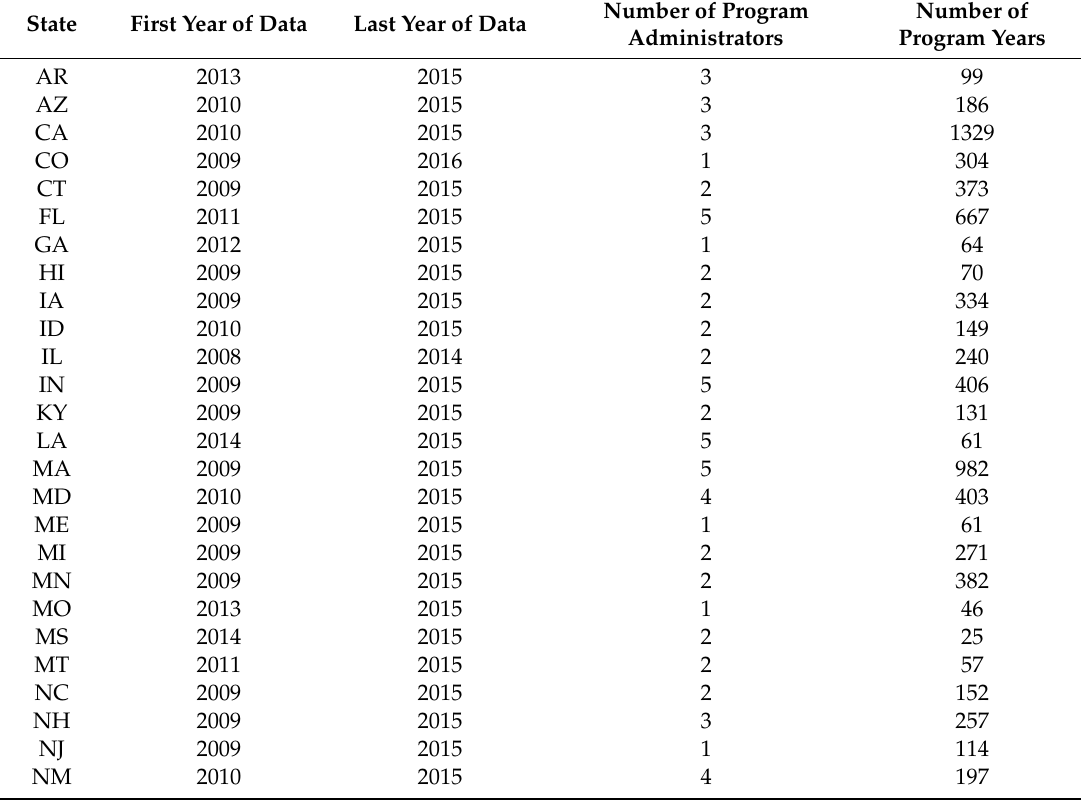
Table A1. Summary of program data in the LBNL Cost of Saving Electricity